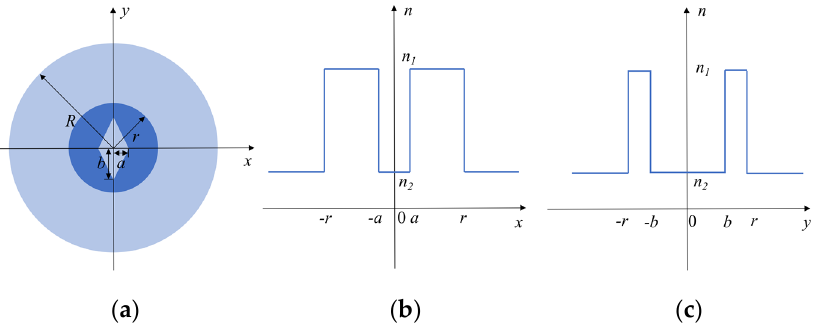
Figure 1. ( a ) The cross − section of diamond − assisted ring − core fiber (DRF); ( b ) refractive index distribution in x -axis direction; ( c ) refractive index distribution in y -axis direction.